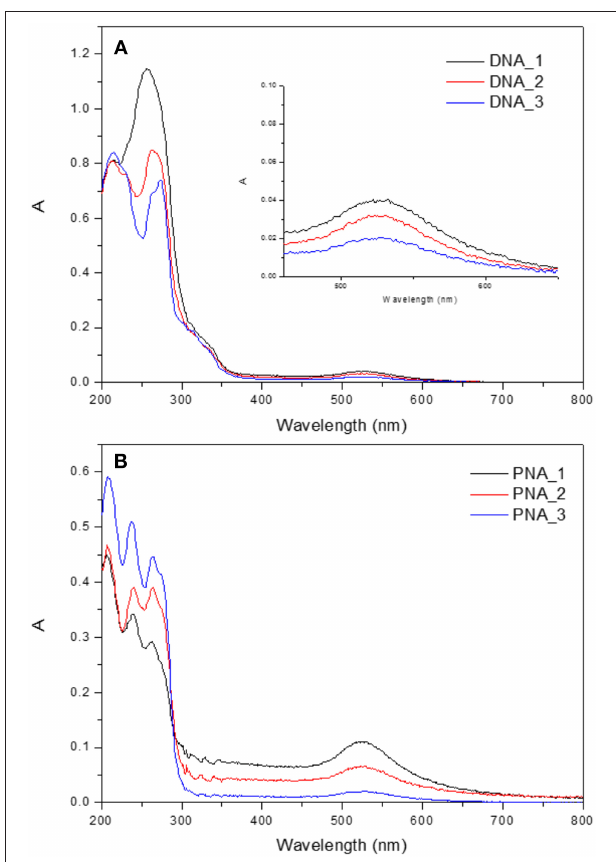
FIGURE 5 | UV-Visible absorption spectra of (A) DNA_1-3 and (B) PNA_1-3 samples.